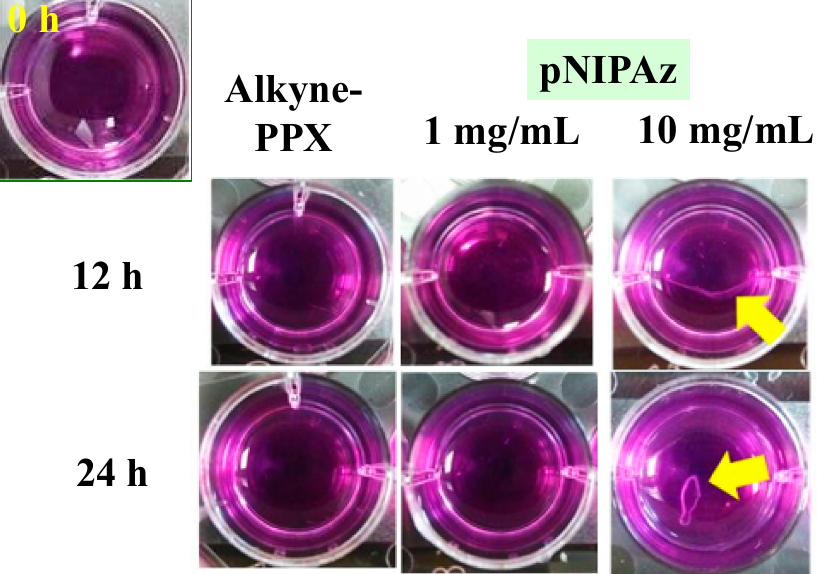
Figure 5. The temperature responsive release of C2C12 cell sheets. Alkyne-PPX was deposited on TCPS and then conjugated with p (NIPAz) at 1 or 10 mg/mL. After cultured for 24 h at 37 °C, the plate was placed at room temperature. The yellow arrows indicate the detached cell sheet.